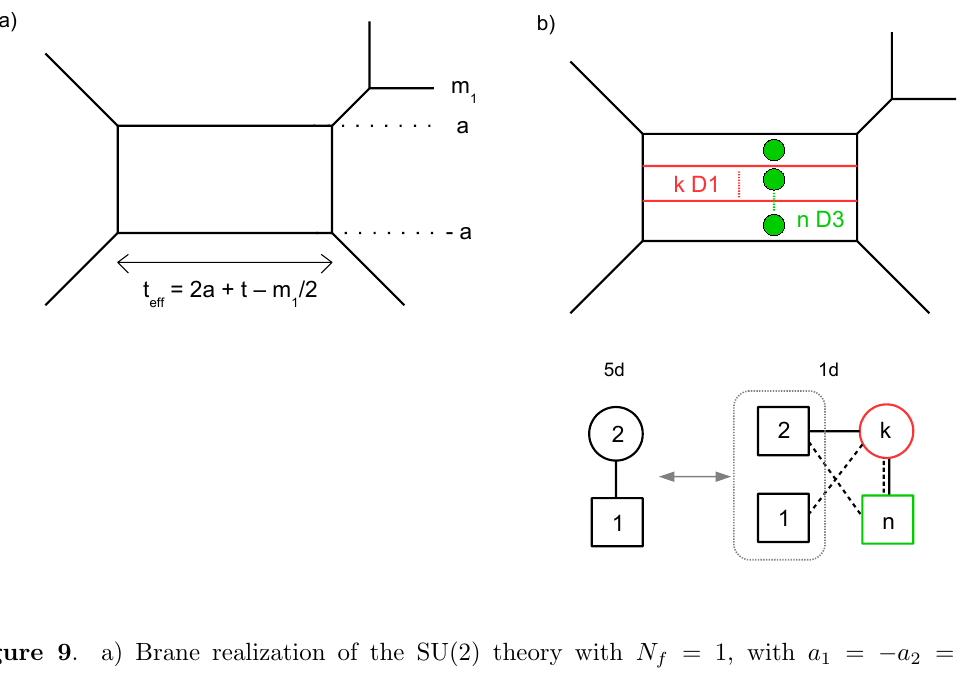
Figure 9 . a) Brane realization of the SU(2) theory with N f = 1, with a 1 = (cid:0) a 2 = a . b) Brane setup and ADHM quiver SQM for the k -instanton sector in the presence of an n D3 branes SQM